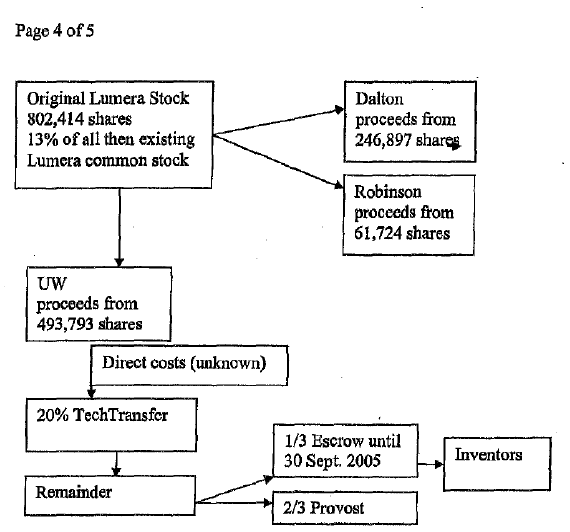
Figure 7: Flow chart of Lumera stock distribution from UW TechTransfer memo.